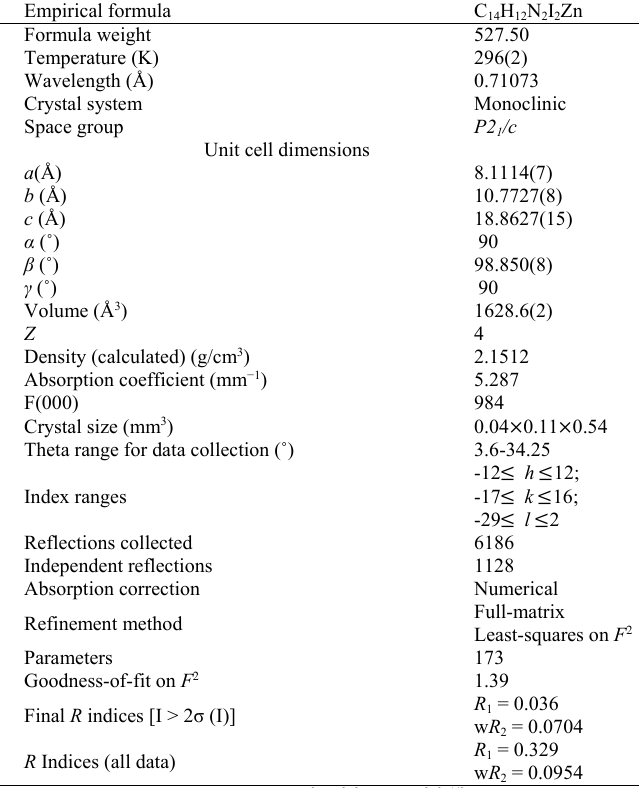
Table 2. Crystal data and structure refinement for compound 1.